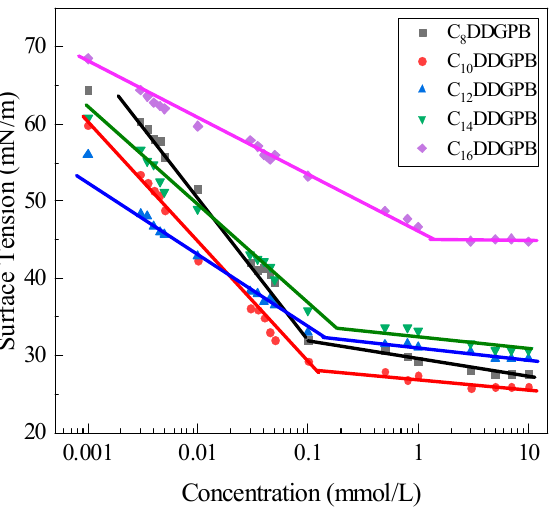
Figure 1. Surface tension of double-chain quaternary ammonium salt glucosamide surfactants in aqueous solution as a function of concentration.